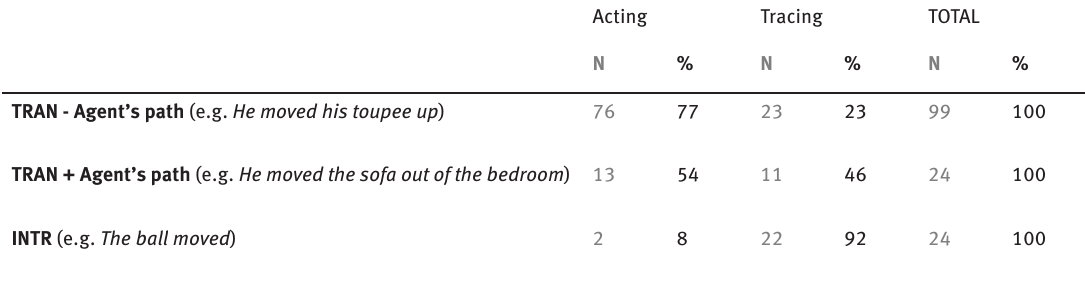
Table 9. Gestural Modes of Representation with respect to the causative-inchoative alternation with and without the Agent’s path